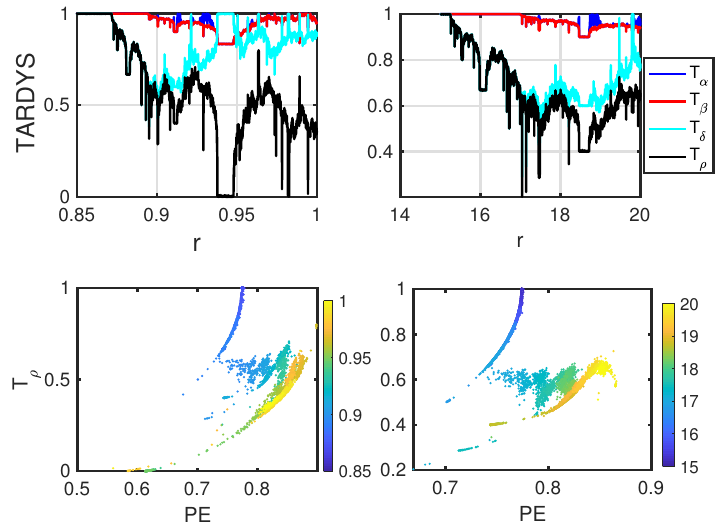
Figure A3. TARDYS quantifiers and T ρ versus PE for the sine map and Ricker’s population